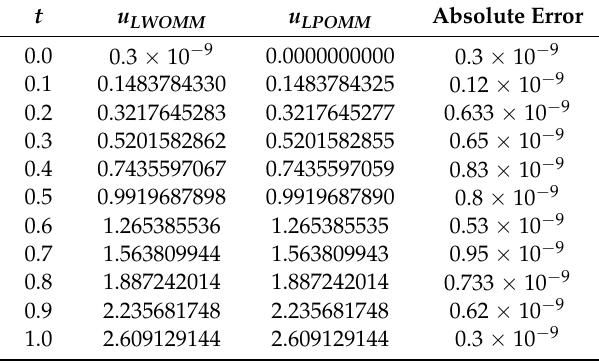
Table 1. Numerical solutions of u ( t ) when α = 0.9 attained by the introduced method and the LPOMM for Example